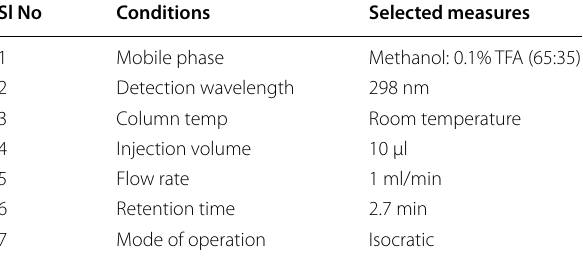
Table 1 Chromatographic condition for assessment of